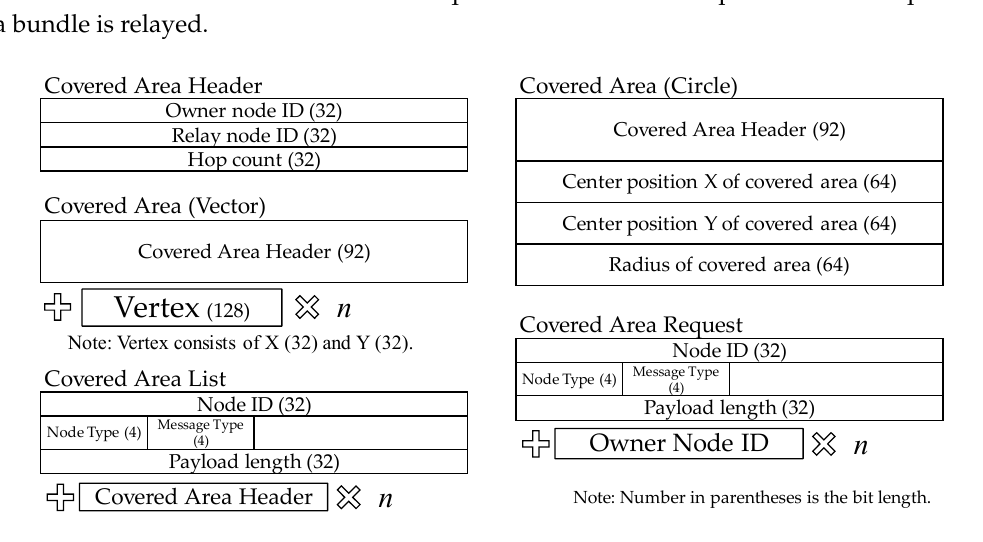
Figure 14. Structures of the messages exchanged between relay nodes.